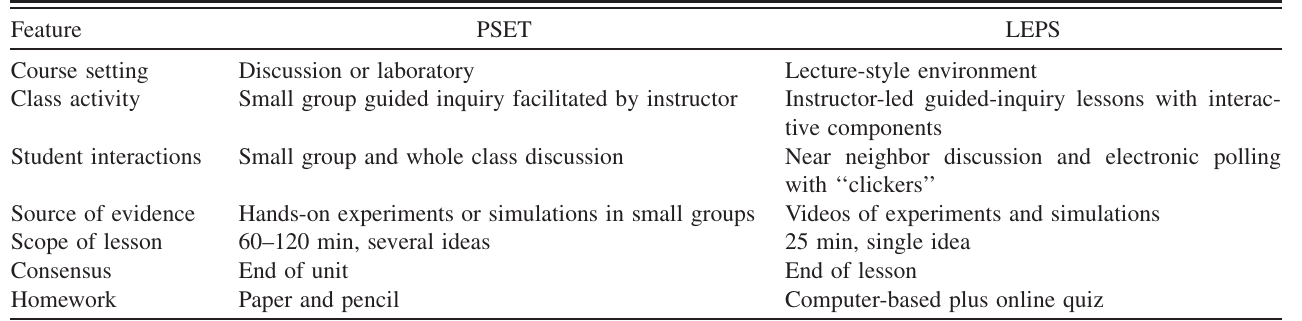
TABLE I. Features of PSET and